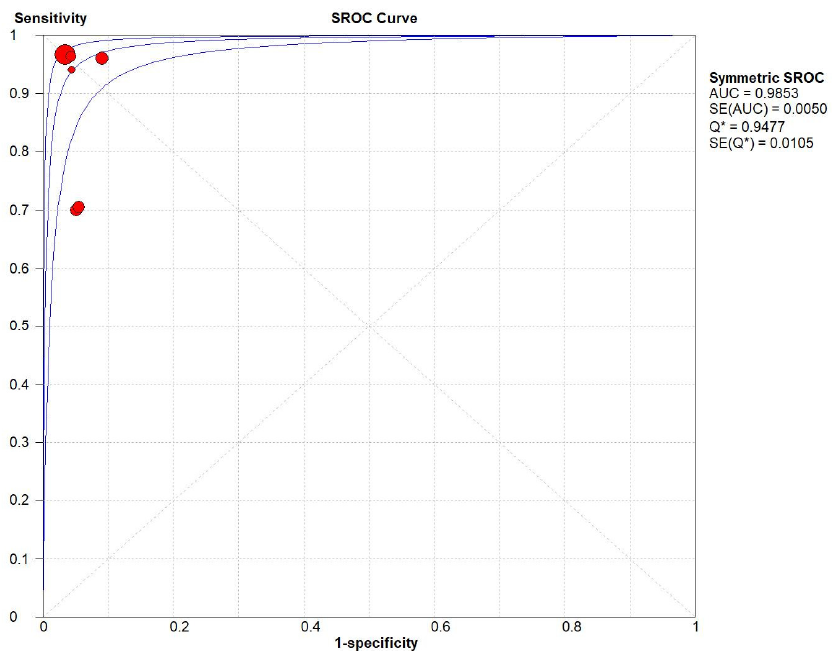
Figure 4. Summary receiver operating characteristics (sROC) curve, the calculated area under the curve (AUC) = 0.985. SROC: summary receiver operating characteristics; SE: standard error; AUC: Area under the curve.